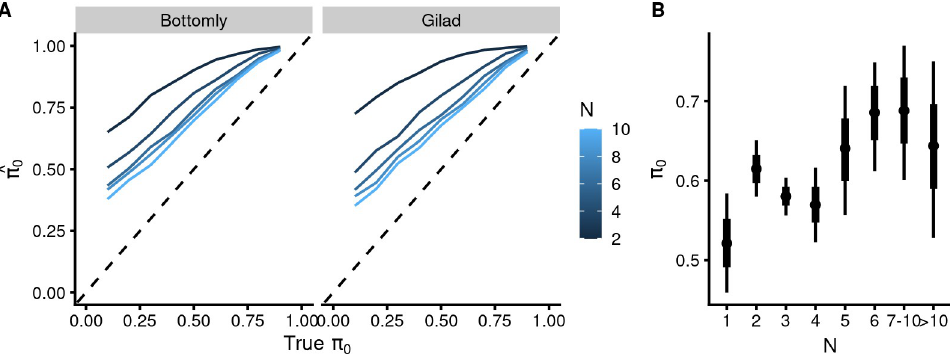
Fig 6. π 0 -s calculated from anti-conservative p-value sets do not behave in accordance to statistical theory. ( A ) Calculated π 0 -s (on the y-axis) from simulated data vs. given “true” proportions of DE-features (on the x-axes). Sample sizes are indicated in color code. The dotted line shows the perfect correspondence between the given π 0 -s and the estimated π 0 . The data file is in S11 Data. ( B ) Dependence of mean π 0 from the binned sample sizes with 95% CI. Robust linear model [pi0 ~ N], Student’s likelihood. Points denote best estimates for the mean and thick and thin lines denote 66% and 95% credible intervals, respectively. The data file is in S12 Data. Model object related to panel B can be downloaded from